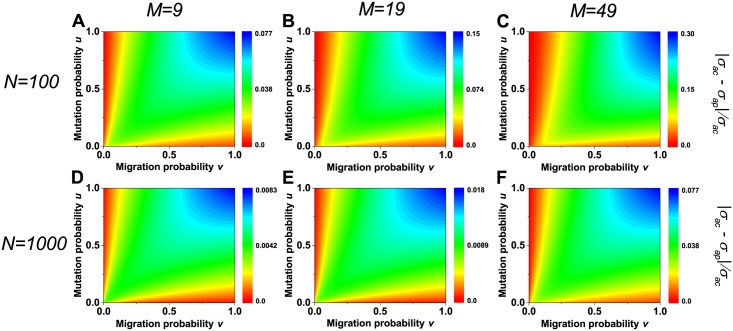
Comparison of the accurate structural coefficientσac and the approximate one σap across the parameter space (v, u).A population of size N = 100 (A, B, C) or N = 1000 (D, E, F) is distributed over M = 9 (A, D), M = 19 (B, E), M = 49 (C, F) groups, respectively. The relative difference of σac and σap, |σac−σap|/σac, decreases as N rises (each column) or as M diminishes (each row), and it is small when u or v is low (each panel). Note the same color in all panels represents different values.